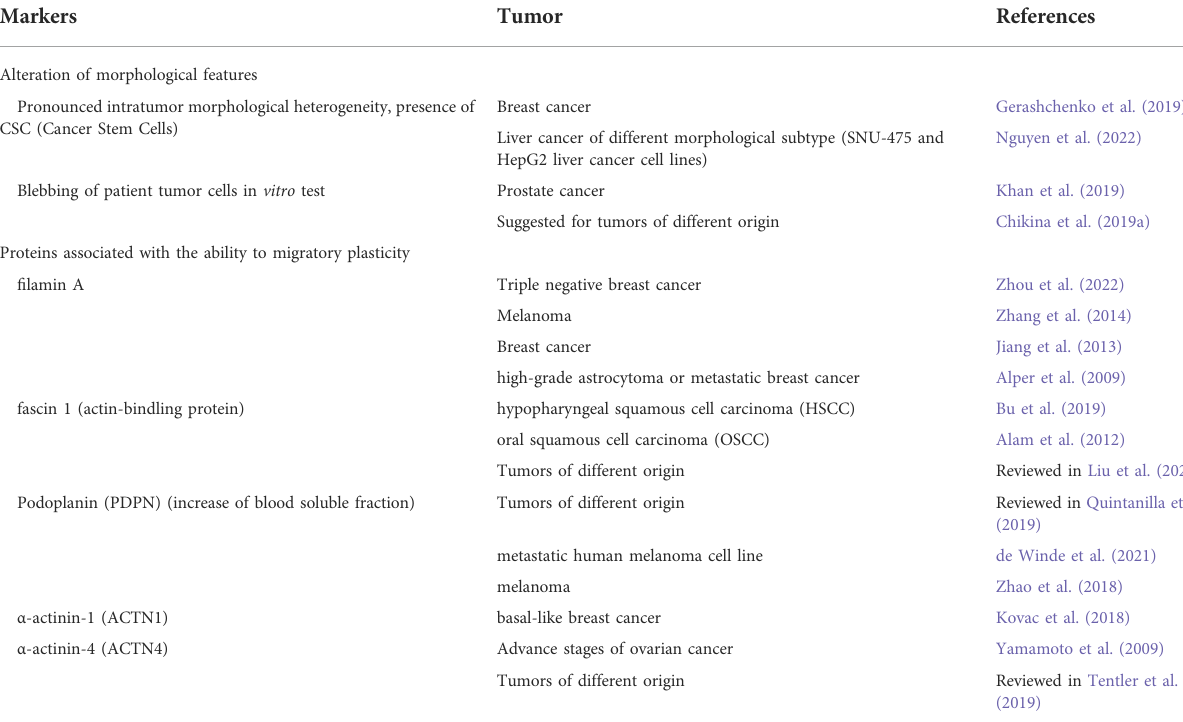
TABLE 2 Markers to predict tumor migration